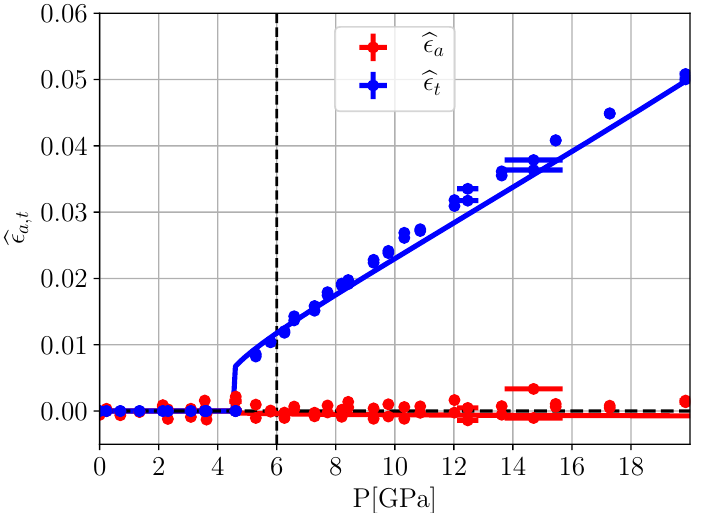
Figure 12. Parametrization of spontaneous strains (cid:98) (cid:101) a , (cid:98) (cid:101) t in comparison to experimental data from Ref. [11]. The thin vertical line indicates the pressure parameter P 0 = 6